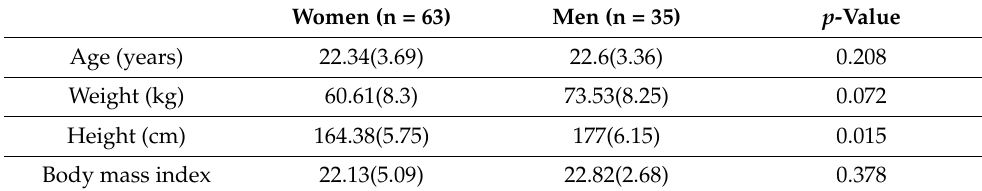
Table 1. Participants (cid:48) characteristics mean (SD).